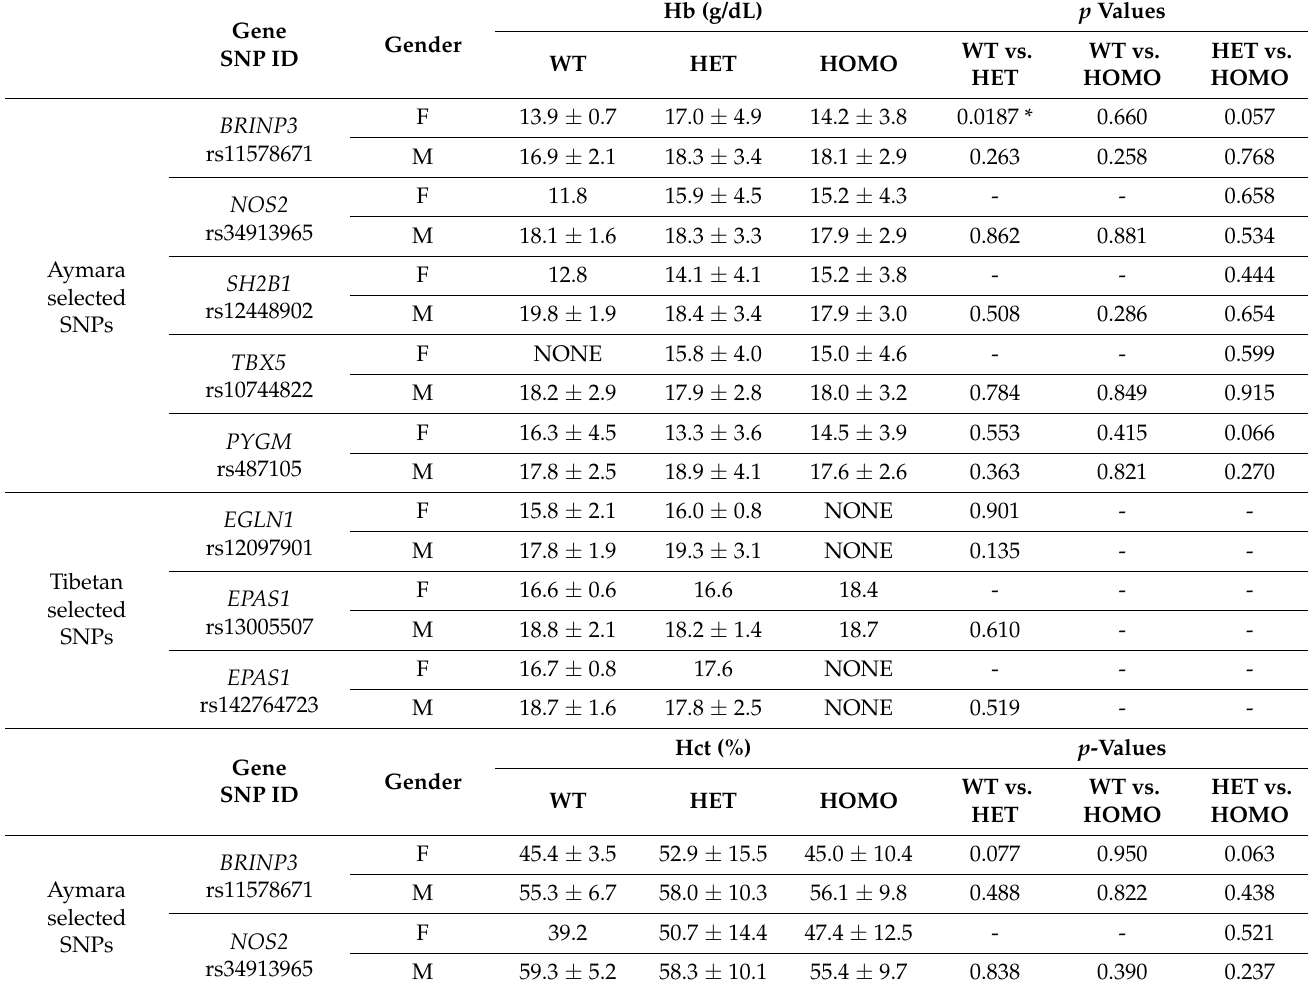
Table 3. Correlation of genotypes to hemoglobin (Hb) and hematocrit (Hct) at 4000